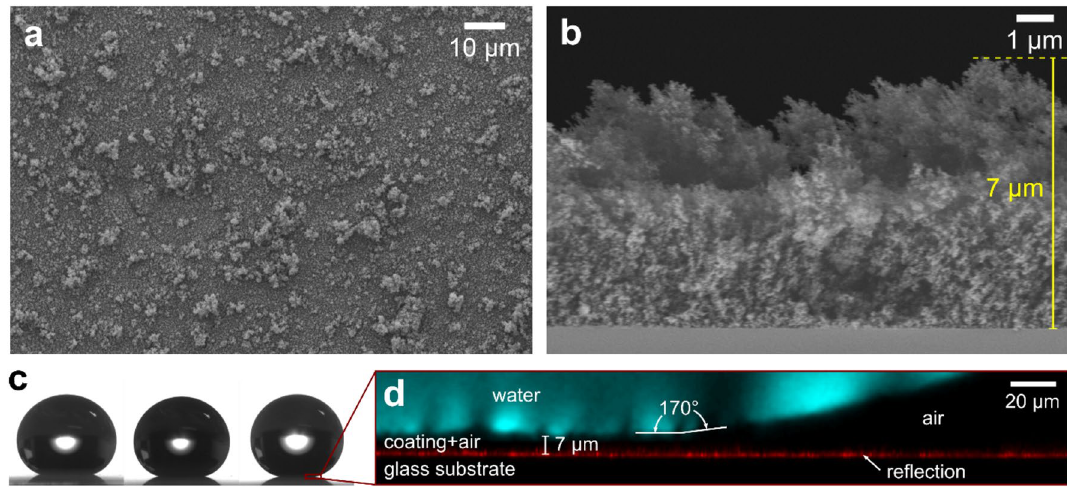
Figure 1. ( a ) Top-view and ( b ) cross-sectional SEM images of a superamphiphobic coating, ( c ) shape of 6 μL drops of (from left to right) hexadecane, ethylene glycol and water resting on the surface, and ( d ) laser scanning confocal microscopy image of a water drop labeled with fluorescent dye (1 mg L −1 ).